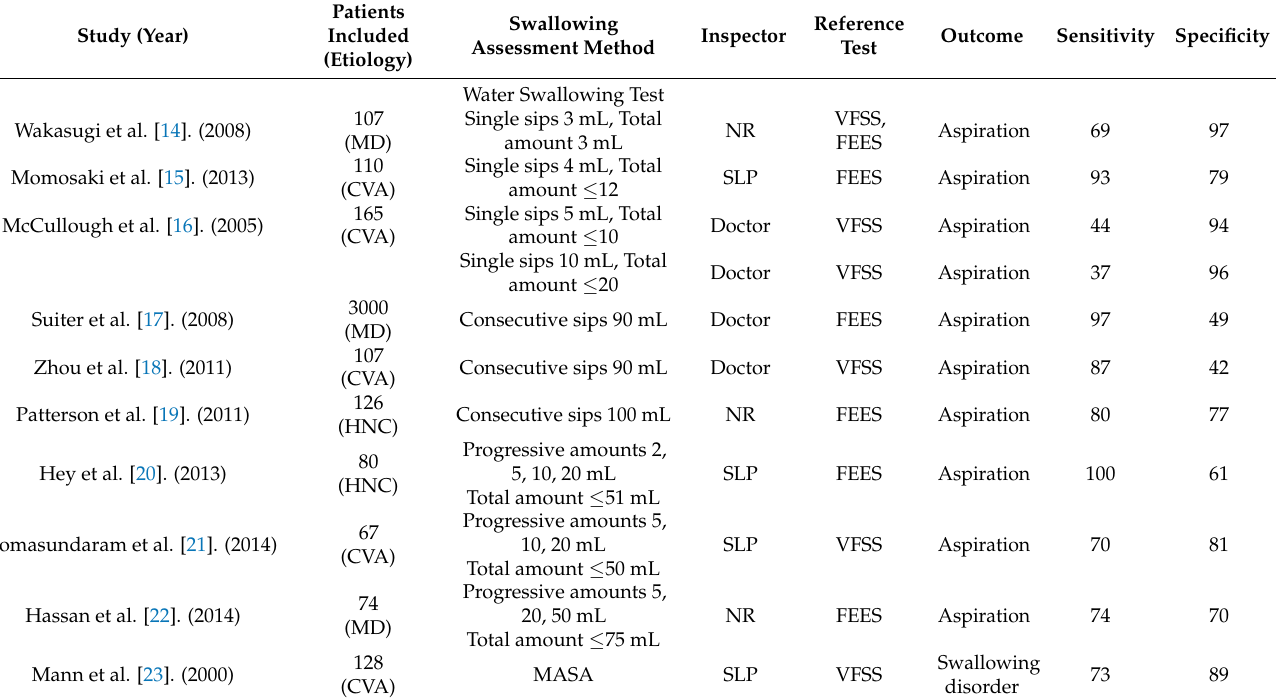
Table 1. Dysphagia screening methods (sensitivity and